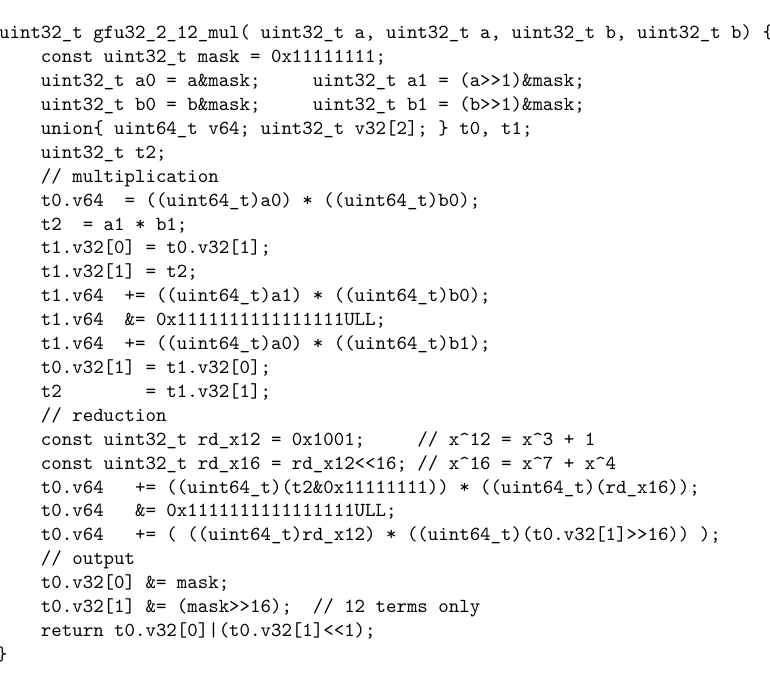
for data in radix-16 format 2 12